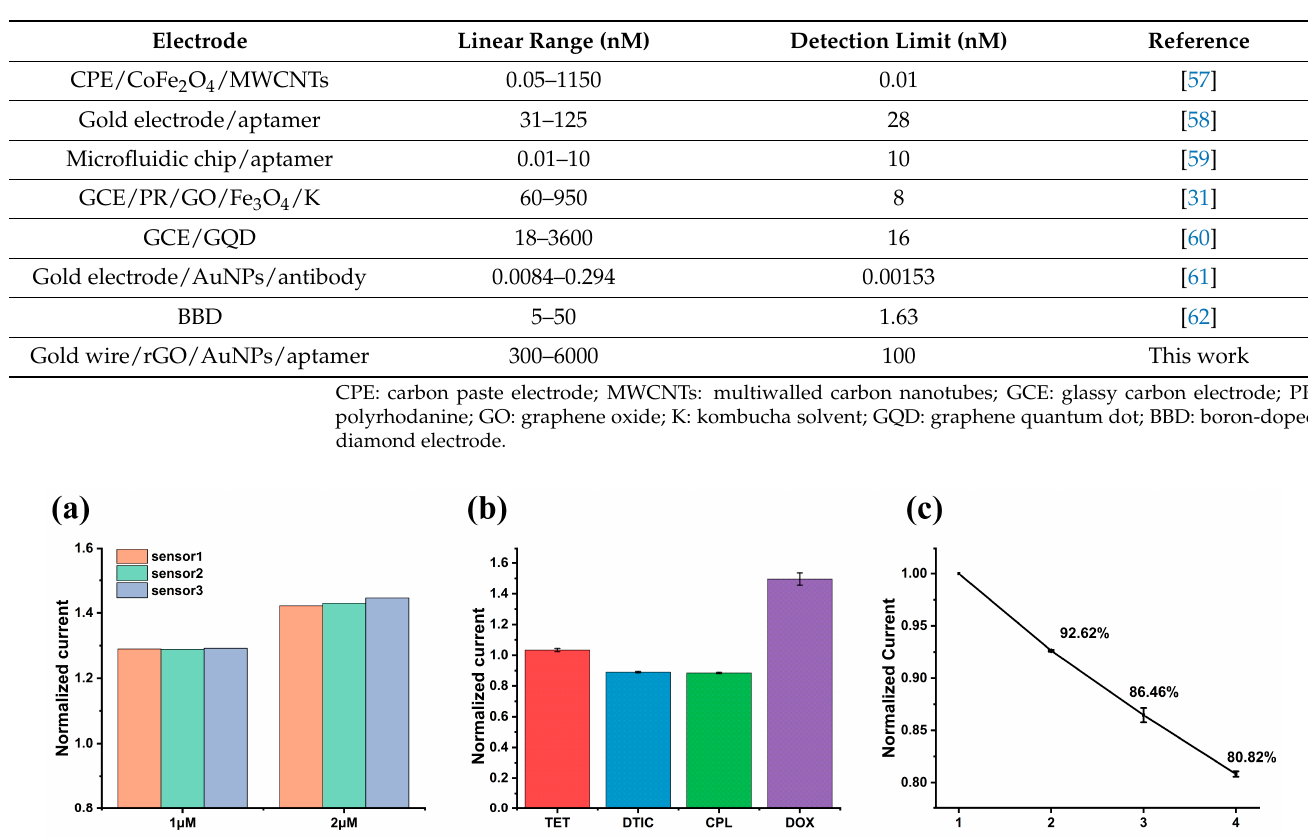
Table 1. Comparison of our work with the recently published electrochemical method for the determination of DOX.